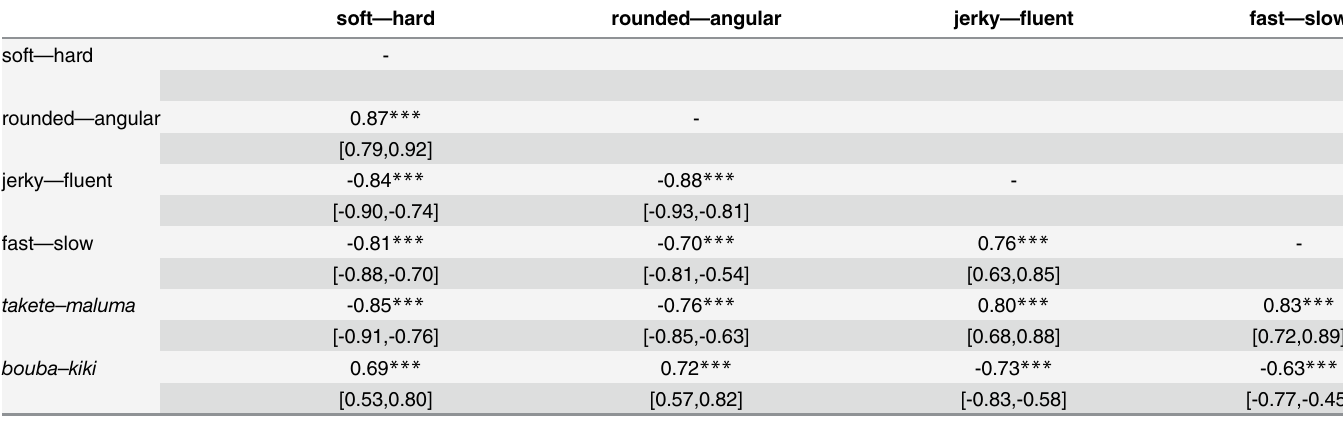
Table 2. Pearson Correlations of Verbal Descriptors of Body Motion with takete - maluma and bouba - kiki